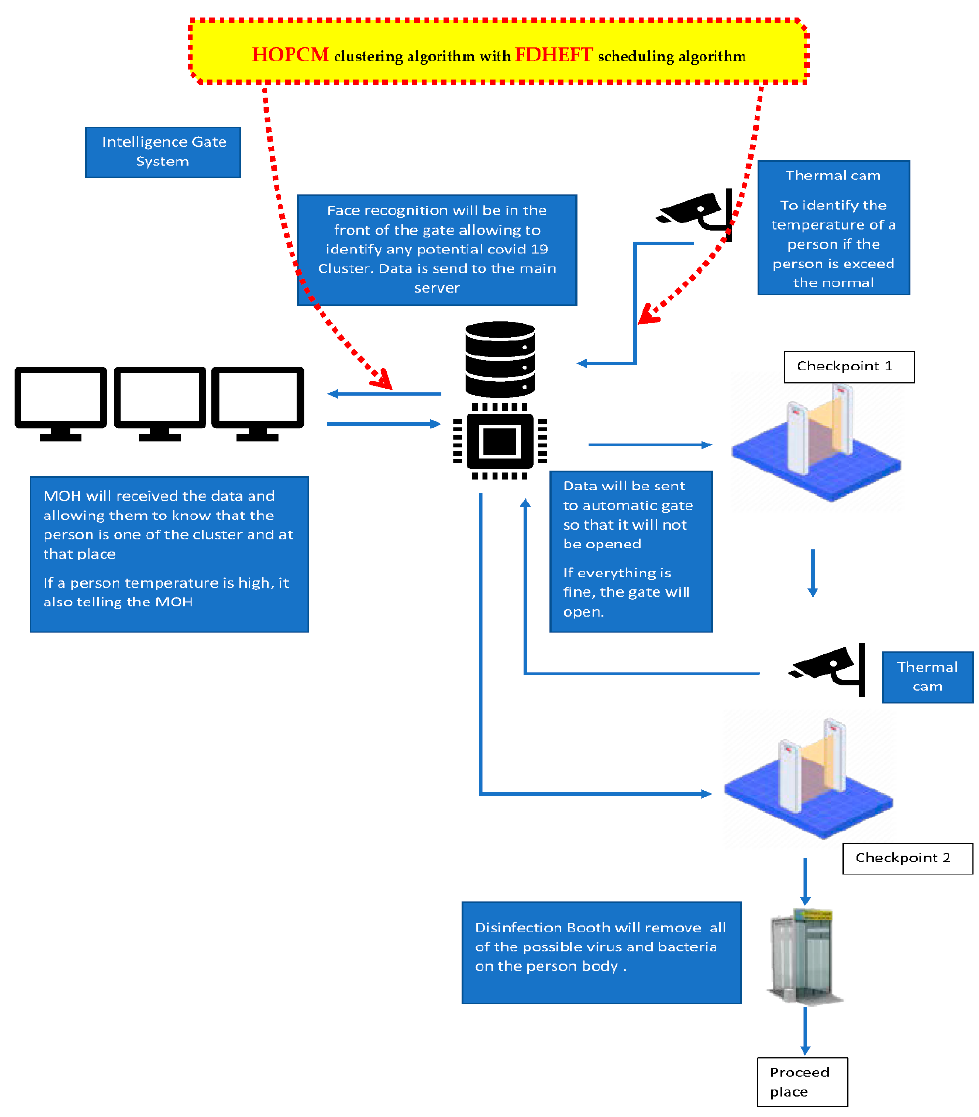
Figure 8. Cloud intelligent gate system.